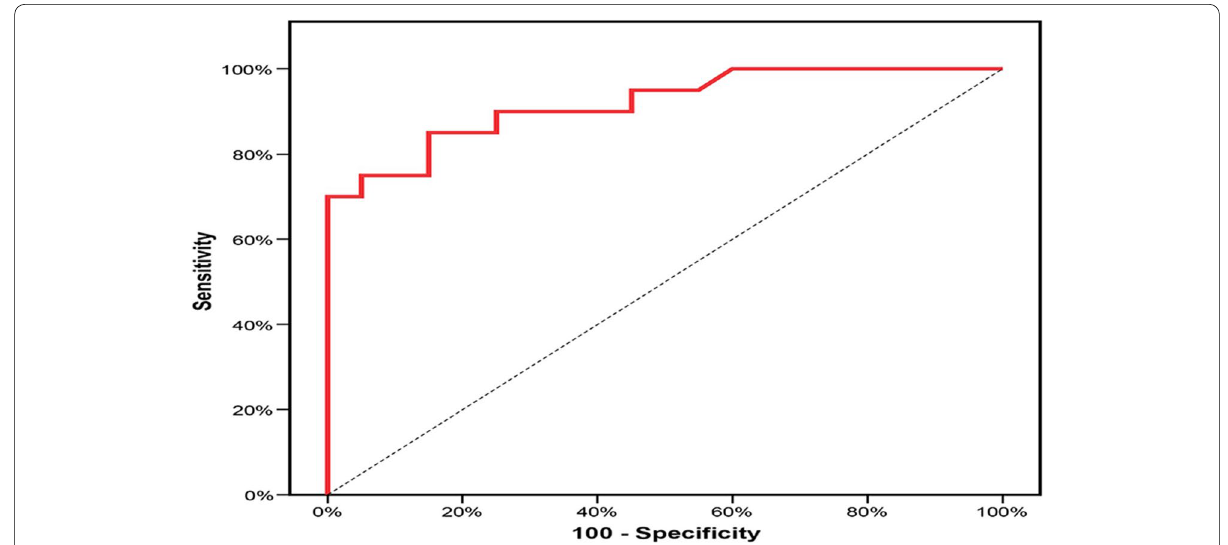
Fig. 5 ROC curve for serum YKL‑40 to discriminate group II ( n Table 5 Validity (AUC, sensitivity, specificity) for serum YKL‑40 to discriminate group III ( n